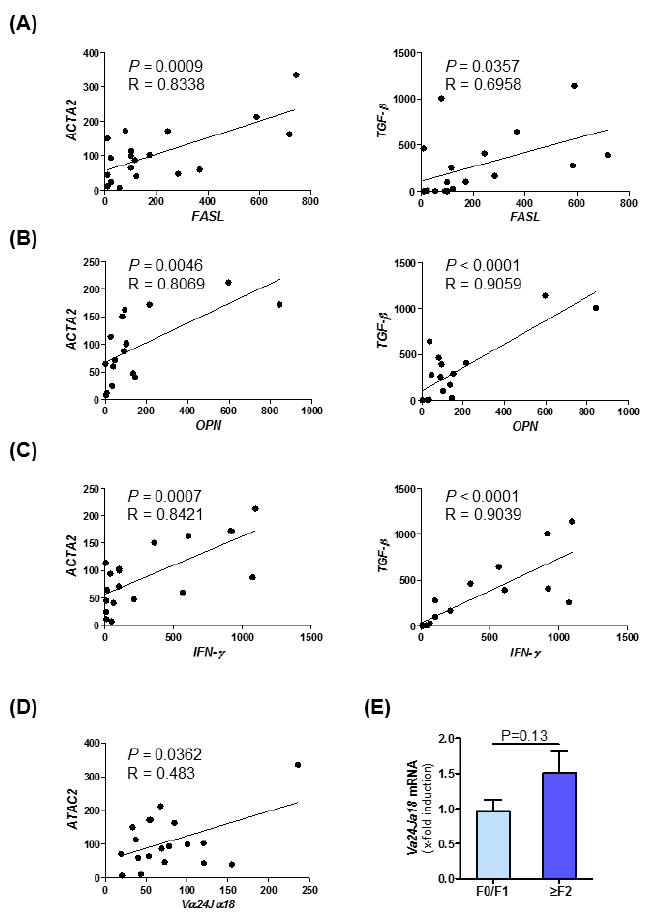
Figure 6. Expression of NKT cell marker correlates with fibrosis markers of patients with non- alcoholic steatohepatitis. Correlation analyses of mRNA expression level in NASH patient samples were performed by qRT-PCR analysis. There were 22 human samples from liver resections with different stages of steatosis and fibrosis analyzed. ( A ) NKT-associated FASL expression was correlated with ACTA2 (left panel) and TGF- β (right panel) expression. ( B ) Fibrosis-related expression of ACTA2 (left panel) and TGF- β (right panel) were correlated with OPN expression. ( C ) Correlation analysis between ACTA2 (left panel) and TGF- β (right panel) with inflammatory marker IFN- γ ( D ) Expression of ACTA2 were correlated with the type I NKT related gene V α 24J α 18 via qRT-PCR. ( E ) Expression pattern of V α 24J α 18 was measured by qRT-PCR in different fibrosis grades in